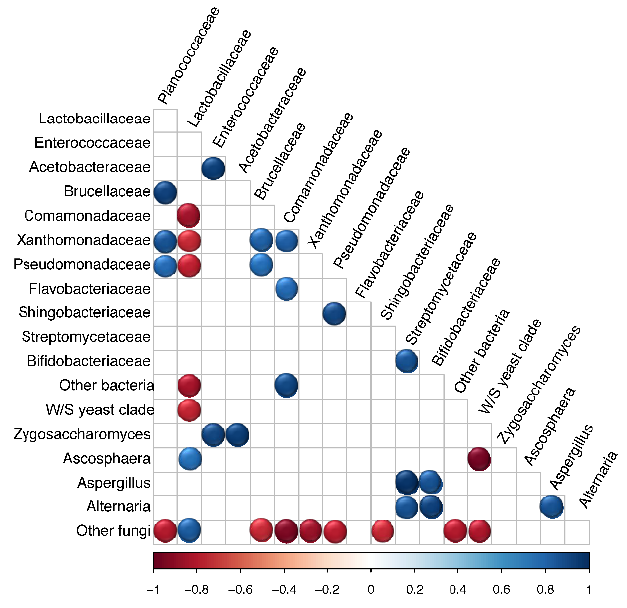
Figure 4. Pearson correlation matrix showing the relative abundance of microbial taxa within bumble bee pollen provisions from both sources ( N = 7). Significant positive and negative correlations are displayed in blue and red circles, respectively ( p < 0.05). Color intensity is proportional to the correlation coefficients.